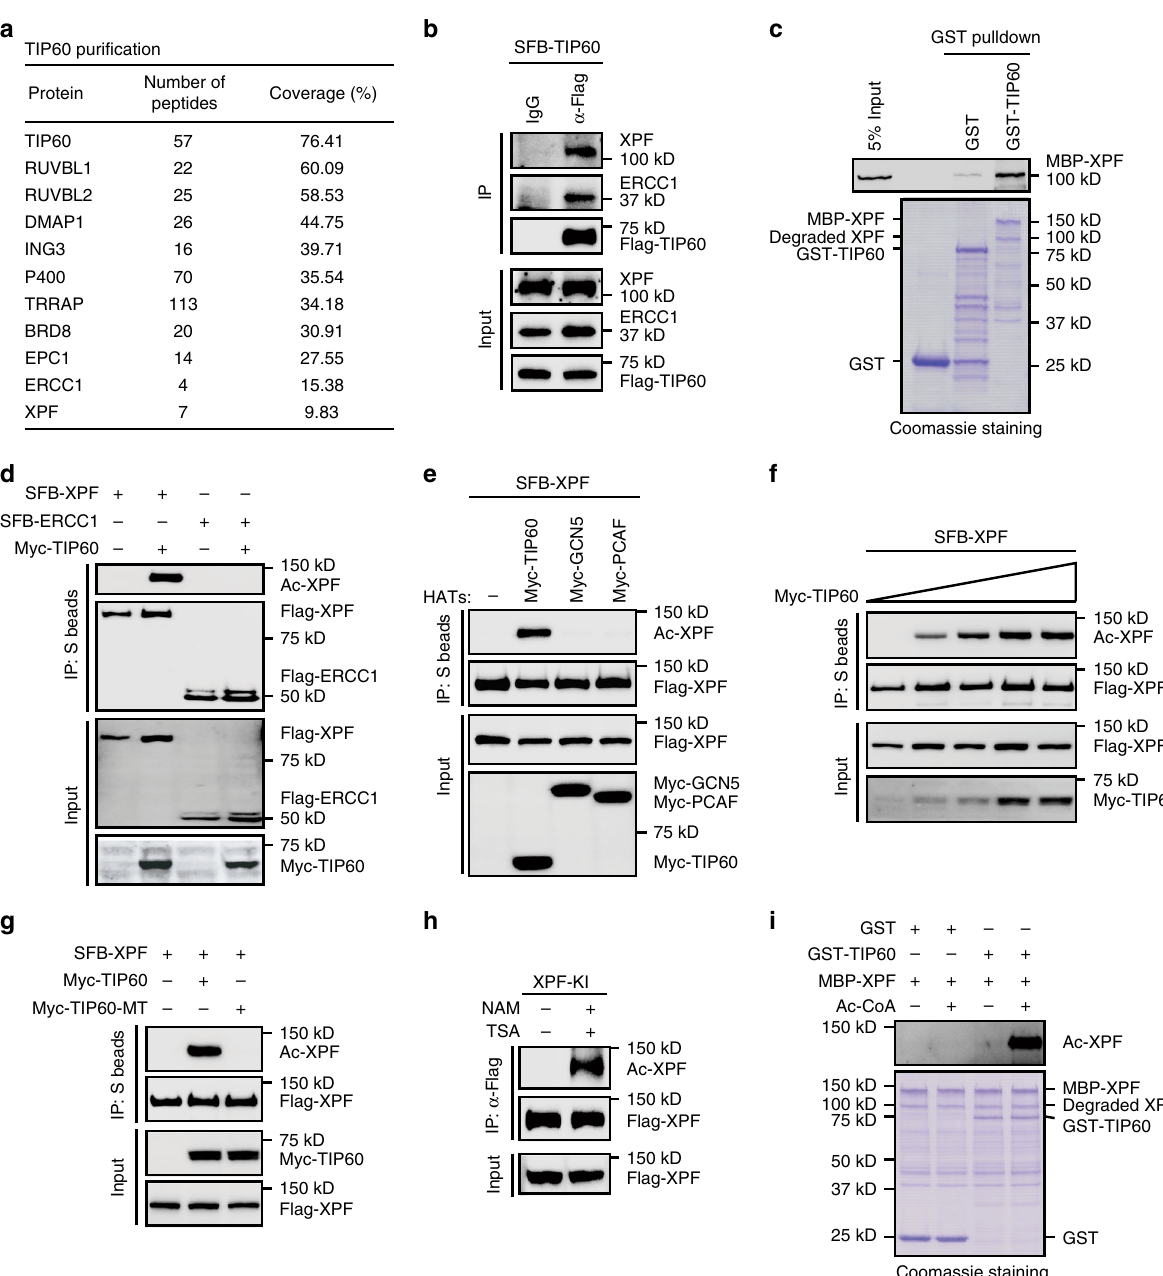
i TIP60 acetylates XPF in vitro. MBP-tagged XPF, GST, or GST-tagged TIP60 were puri fi ed from E. coli . The puri fi ed proteins were then incubated in reaction buffer in the presence or absence of the acetyl-CoA (2 mM) at 37 °C for 30 min. Upper panel: XPF acetylation was detected by immunoblotting. Lower panel: Proteins puri fi ed from E. Coli were resolved by SDS PAGE and visualized by Coomassie blue staining. Source data are provided as a Source Data fi